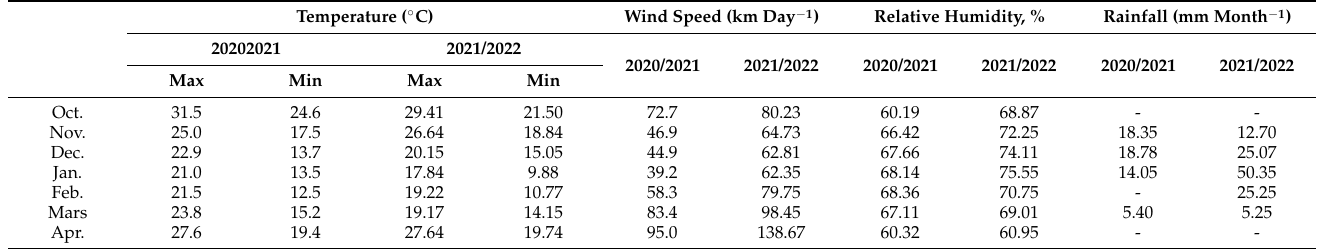
Table 2. Meteorological data during the 2020/2021 and 2021/2021 growing